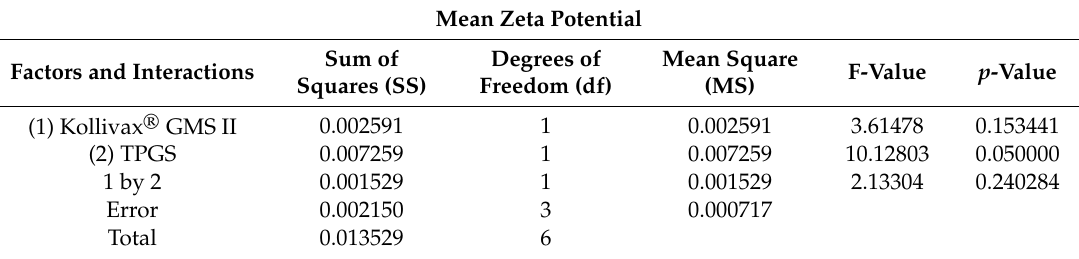
Table 10. Analysis of the mean zeta potential by ANOVA statistical test. Determination coe ffi cient (R 2 ) =